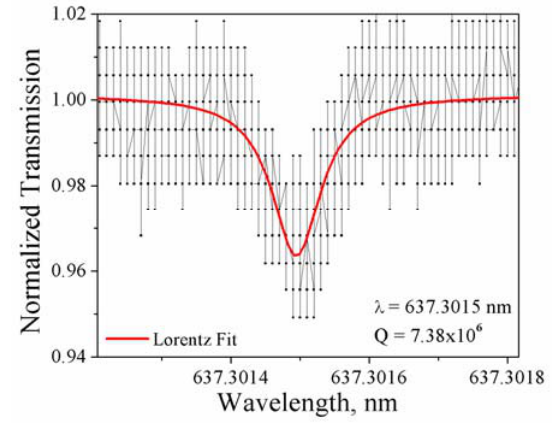
Figure 10. Transmission spectra of biotinylated toroid, showing a single, high-Q resonance (data connected by a solid black line) with the corresponding Lorentz fit (solid red